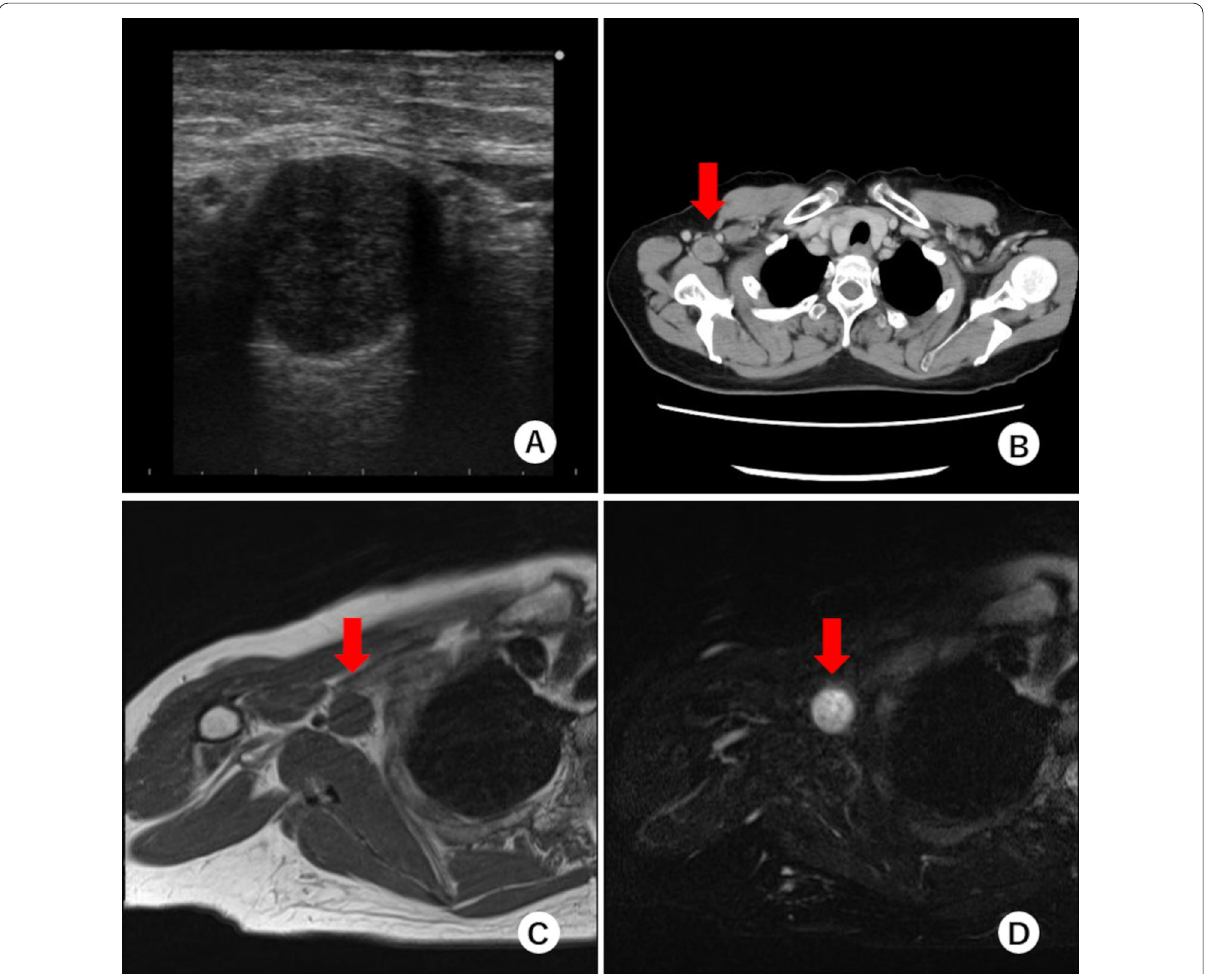
Fig. 2 Imaging studies. A Ultrasonography revealed a well-defined hypoechoic tumor in the right axilla region; B enhanced computed tomography revealed a well-defined round tumor in the right axilla region (red arrow). The tumor was in contact with the axillary vein; C , D magnetic resonance imaging revealed a round tumor which had low intensity on T1-weighted images and high intensity on fat-saturation T2-weighted images in the right axilla region (red arrow)